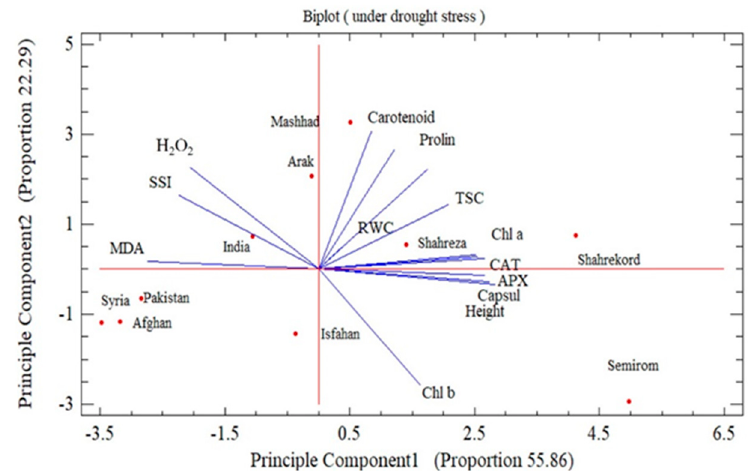
Figure 1. Projection (axis 1 and 2 of a principle component analysis) of physiological, biochemical, and morphological traits of black cumin under water stress (I 3 ) condition.